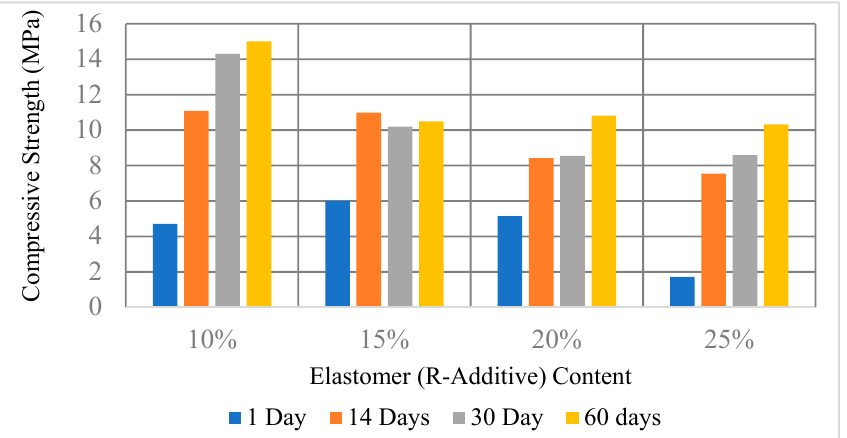
Figure 3. Effects of elastomer (R-Additive) content on compressive strength cured at 60 °C inside the water bath.